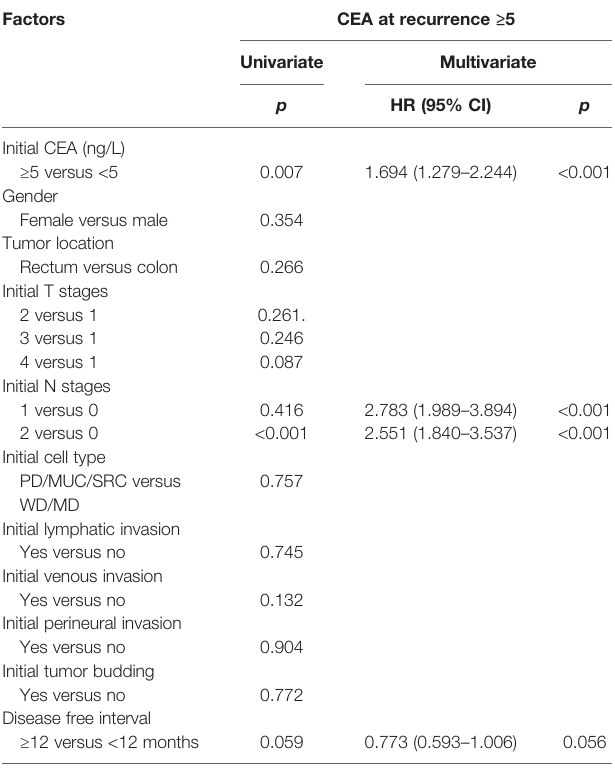
TABLE 3 | Prognostic factors of high CEA at the time of recurrence.